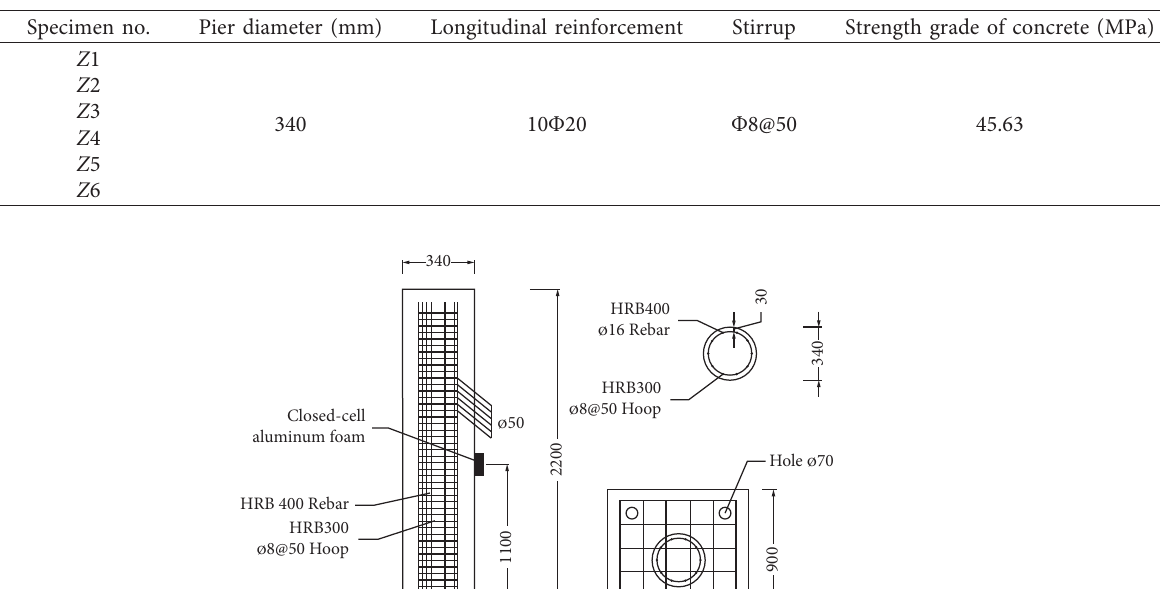
Table 1: Design parameter table of